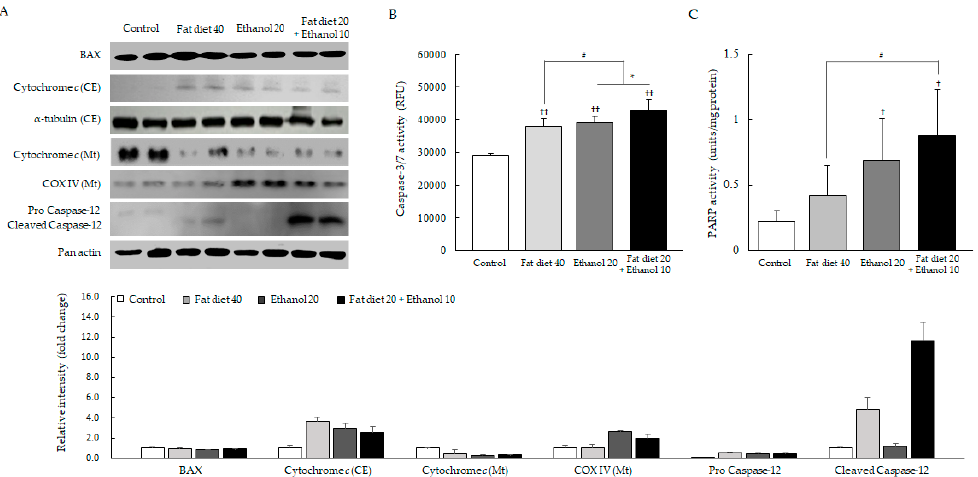
Figure 4. Alterations of apoptosis-related molecules in hepatic tissue. Western blot analysis and relative intensity analysis of apoptosis-related molecules ( A ), caspase 3/7 activity ( B ) and PARP activity ( C ) in hepatic tissue are presented. Data are expressed as the mean ± SD ( n = 6). † p < 0.05 and †† p < 0.01 compared with the control group; # p < 0.05 compared with the fat diet 40 group. * p < 0.05 compared with the ethanol 20 group.